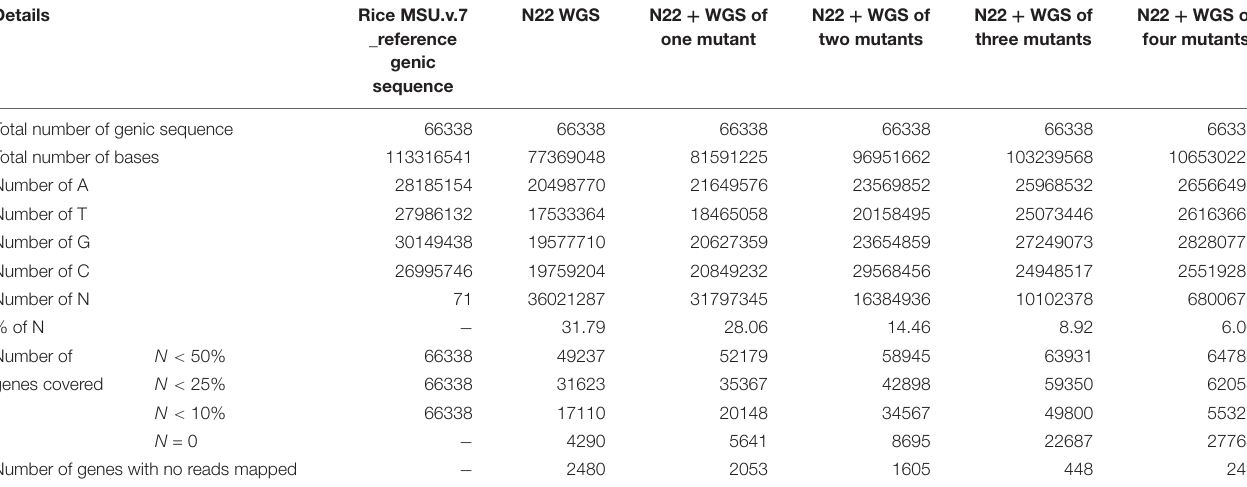
TABLE 3 | Nagina 22 reference gene assembly summary before and after gene polishing using mutant